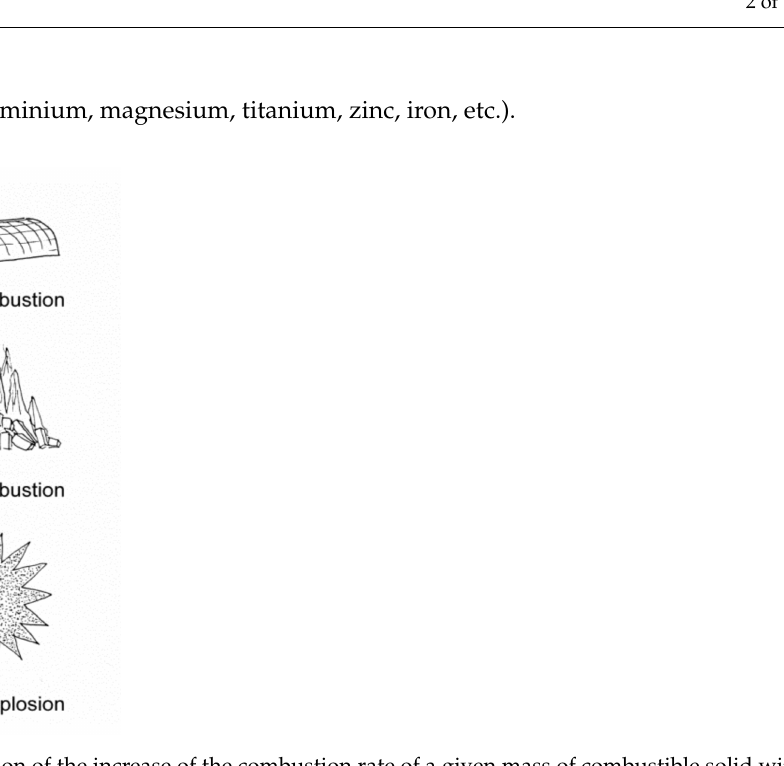
Figure 1. Illustration of the increase of the combustion rate of a given mass of combustible solid with increasing sub-division. From Eckhoff [1–3]. Copyright (2019), with permission from